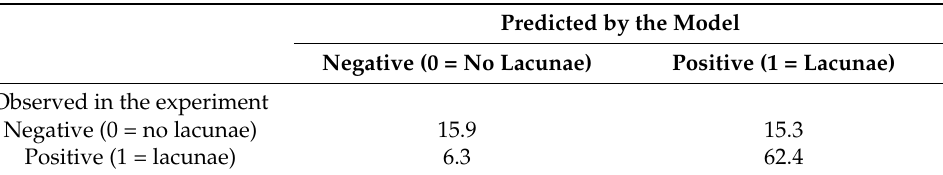
Table 3. Comparison between the predicted classification performed by the logistic regression model and the observed classification in the experiment using a cut point of 0.5.